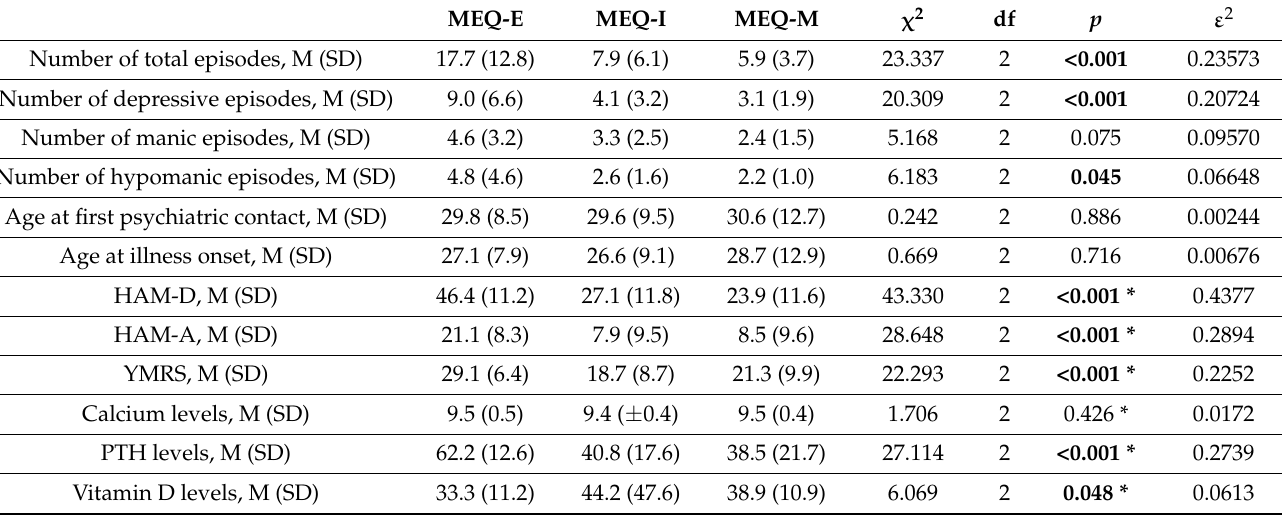
Table 3. Clinical features across different chronotypes: Kruskal-Wallis